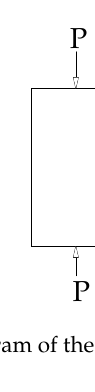
Figure 5. Schematic diagram of pillar and goaf in the abandoned coal mine.